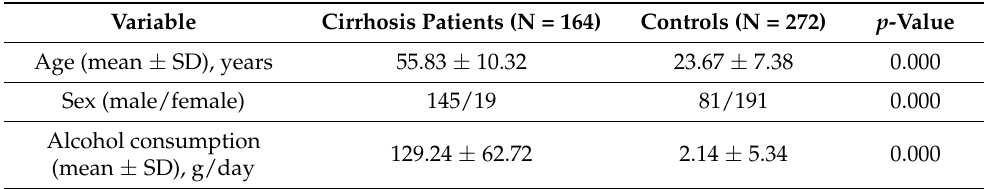
Table 1. Characteristics of individuals included in the